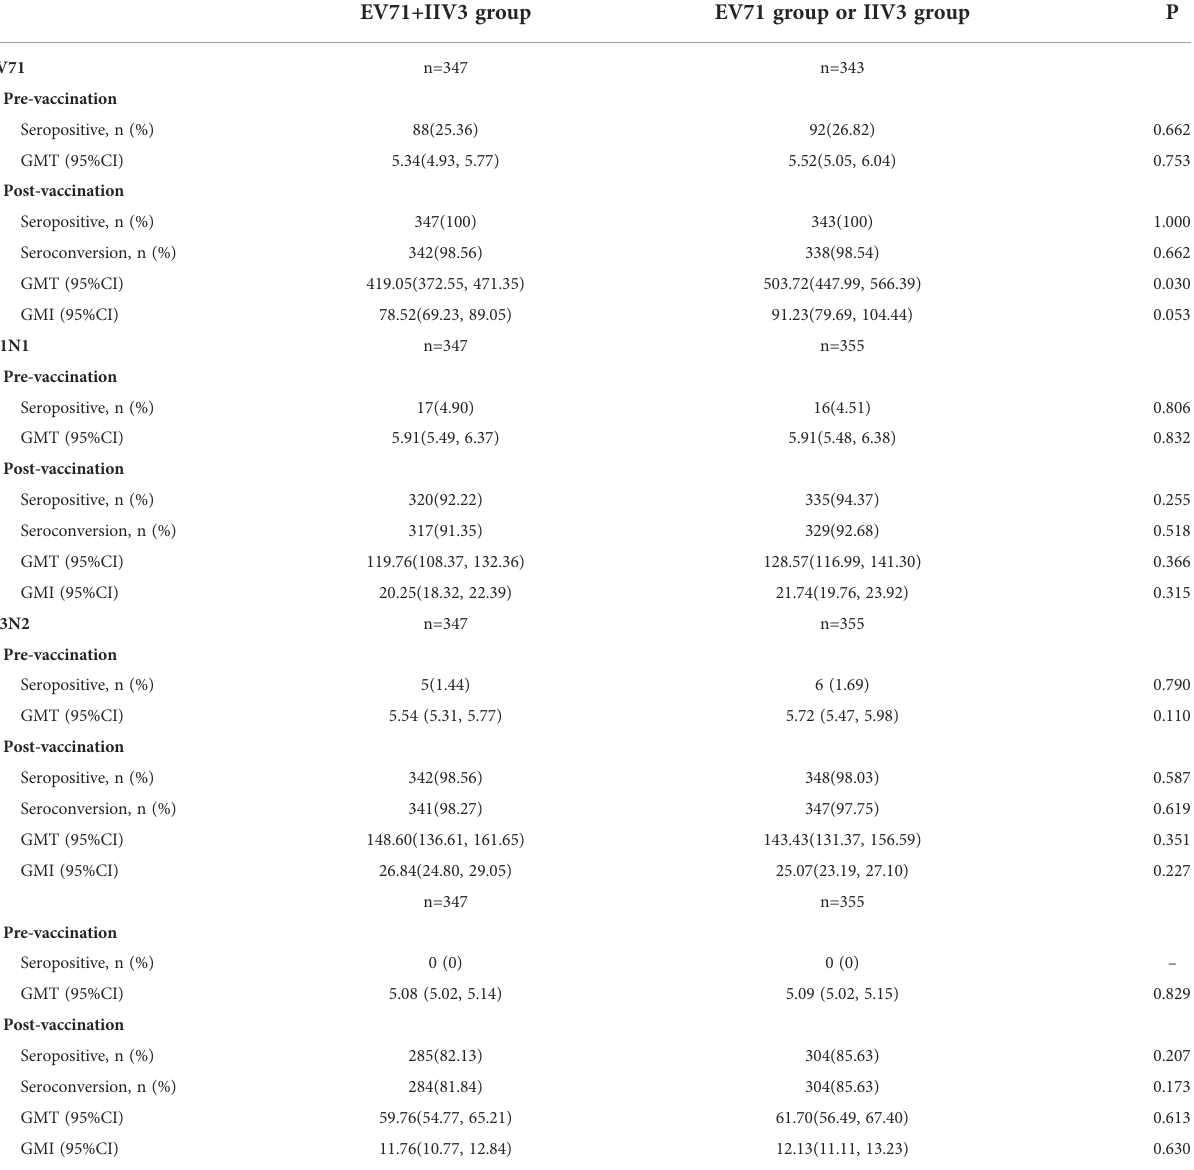
TABLE 2 Antibody responses to EV71, A/H1N1, A/H3N2 and B in the per-protocol population. EV71+IIV3 group EV71 group or IIV3